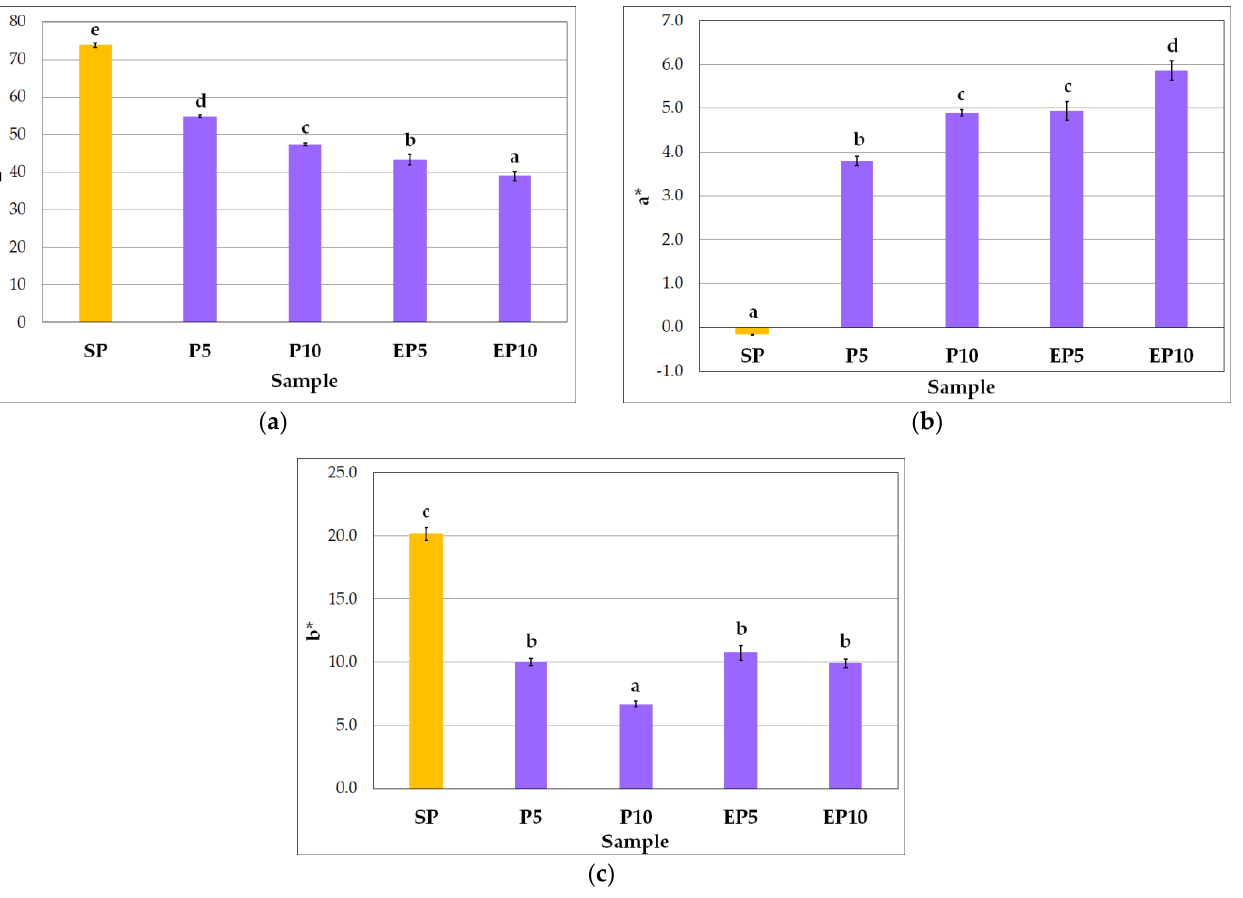
Figure 1. Color parameters of pasta samples: ( a ) L *; ( b ) a *; ( c ) b *. Explanations: SP—semolina-only pasta; P5—pasta with 5% substitution of semolina with non-extruded blackcurrant pomace powder; P10—pasta with 10% substitution of semolina with non-extruded blackcurrant pomace powder; EP5—pasta with 5% substitution of semolina with extruded blackcurrant pomace powder; EP10—pasta with 10% substitution of semolina with extruded blackcurrant pomace powder. Mean values marked with different letters (a–e) are significantly different at significance level of 0.05.